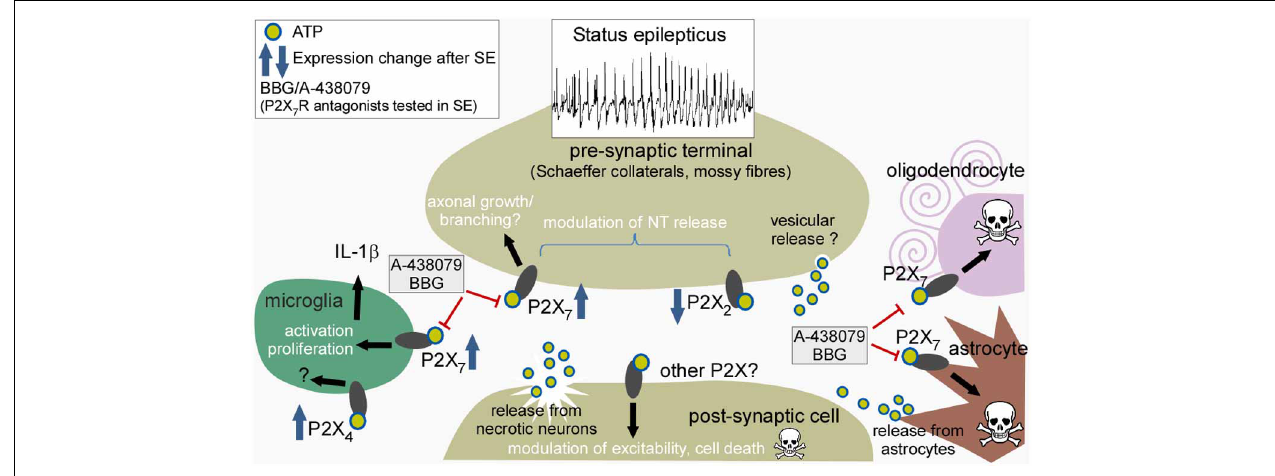
FIGURE 1 | Potential sites of action of ATP released during status epilepticus, expressional responses of individual P2X receptors, and consequences of receptor activation. Cartoon depicts the various different cell types reported to express P2X receptors and their presumed cellular locations. ATP is released during sustained neuronal activity and from damaged neurons to act pre- and post-synaptically on neurons, particularly